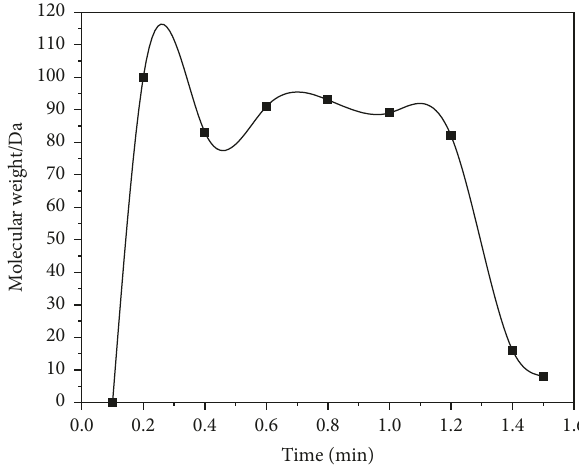
Figure 2: Total ion chromatogram of metabolites in normal humans.